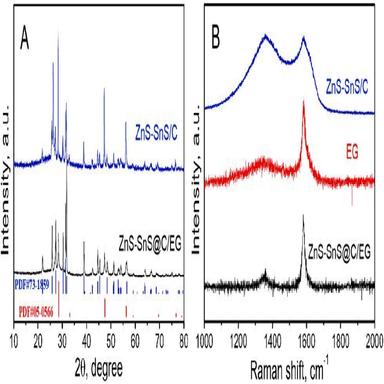
(A) XRD patterns of ZnS-SnS@C/EG and ZnS-SnS/C composite; (B) Raman spectra of ZnS-SnS@C/EG, EG and ZnS-SnS/C composite.